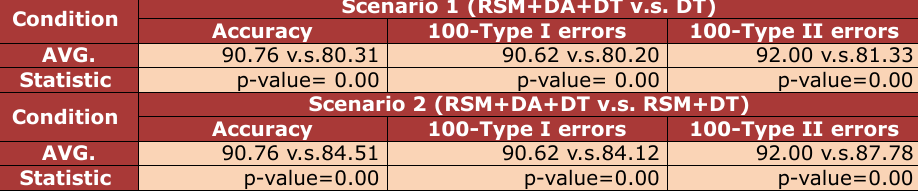
Table 6. The statistic result under two dissimilar